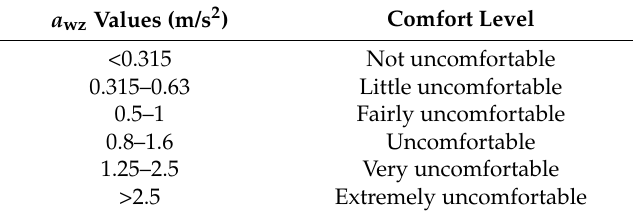
Table 2. Comfort levels related to a wz threshold values as proposed by ISO 2631 for public